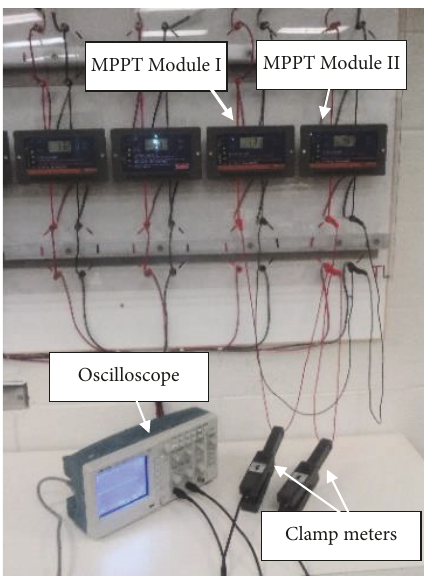
Figure 1: Two parallel-connected MPPT modules.